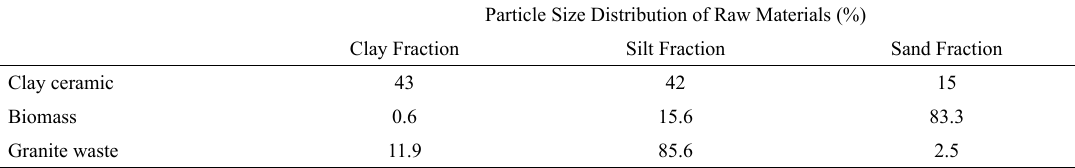
Table 3. Particle size distribution of raw materials (%).